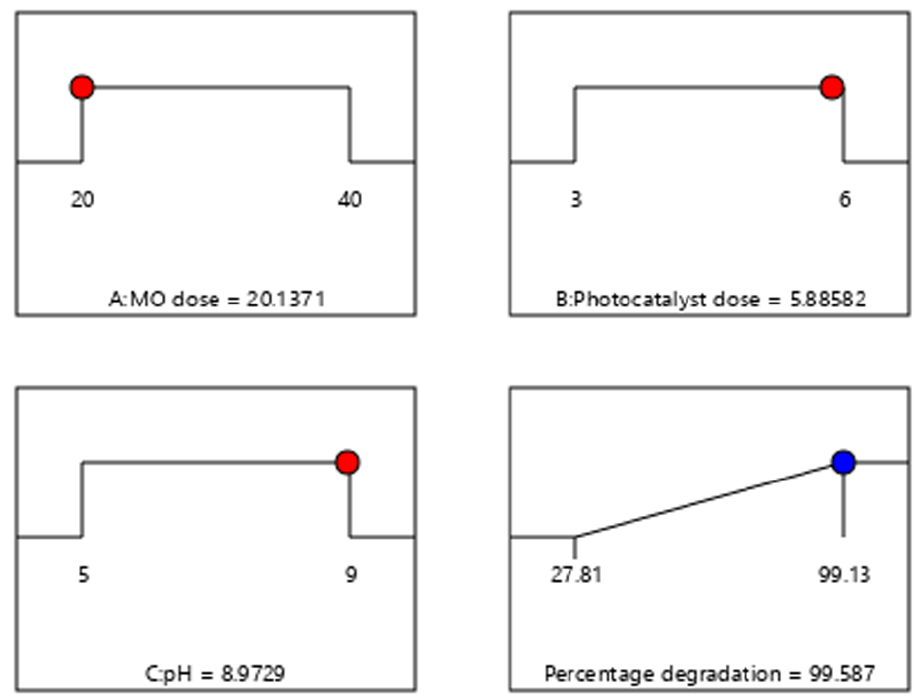
Figure 11. Ramp graph showing the maximum D% values as indicated by the RSM studies.